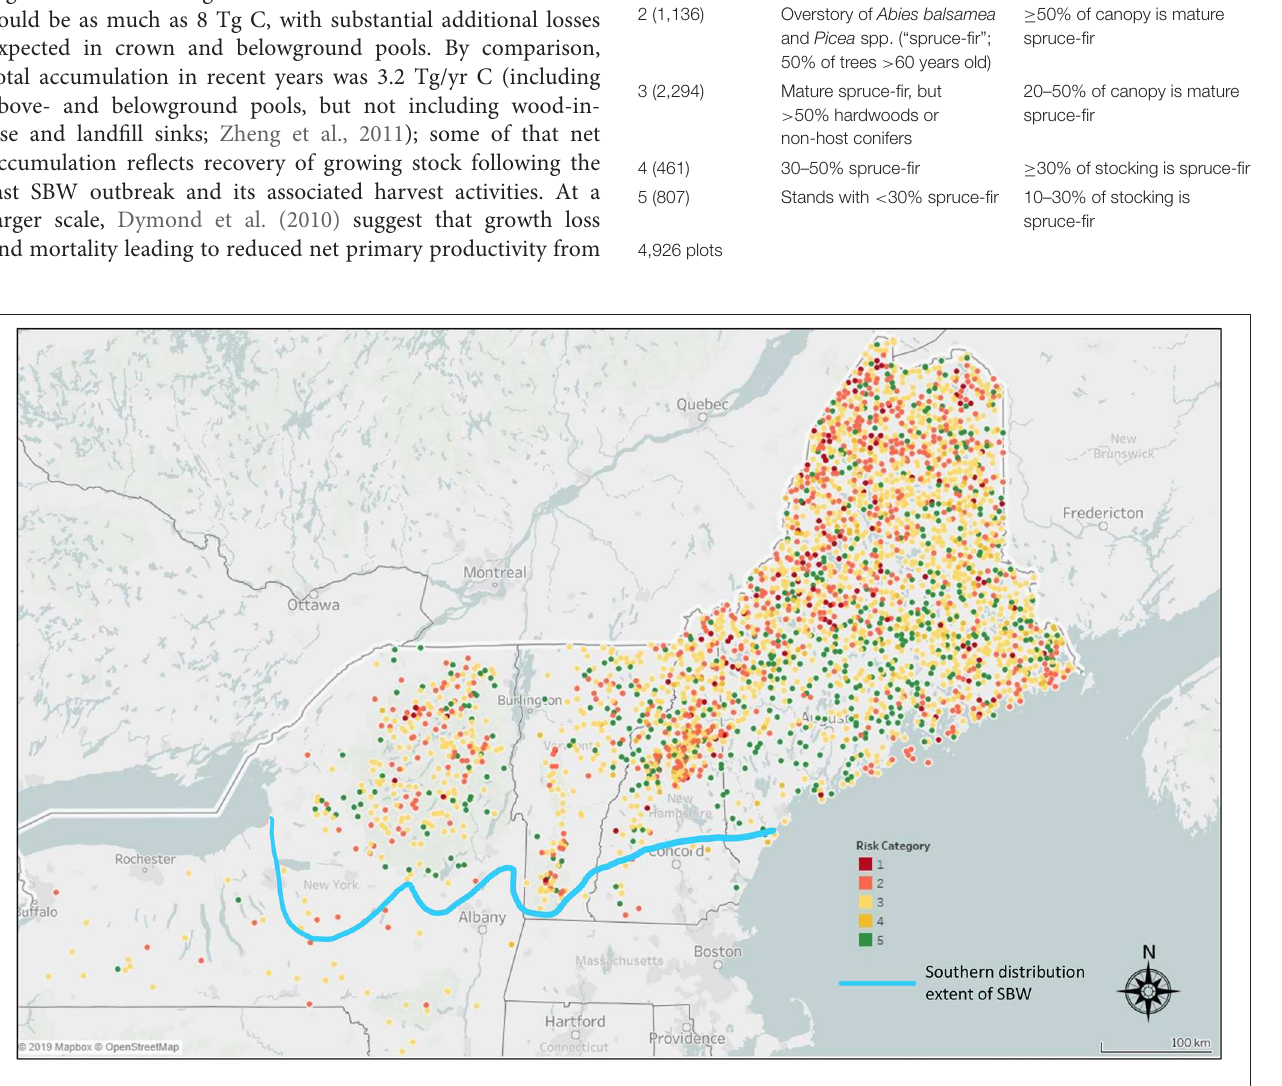
FIGURE 1 | Approximate location of US Forest Service Forest Inventory and Analysis (FIA) plots in the northeastern United States. Colors indicate Risk Category determined by criteria described in Table 2 . Southern range distribution line is adapted from Natural Resources Canada.